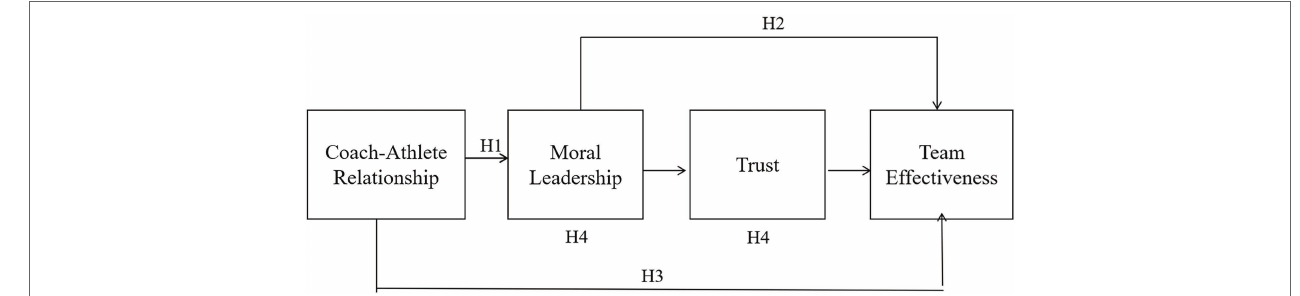
FIGURE 2 | The hypothetical